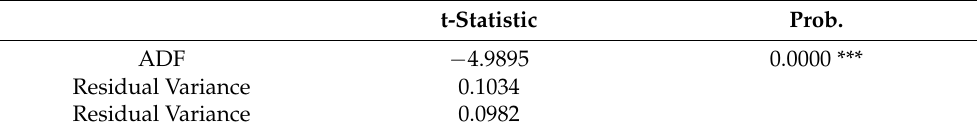
Table 6. Kao Test ADF.